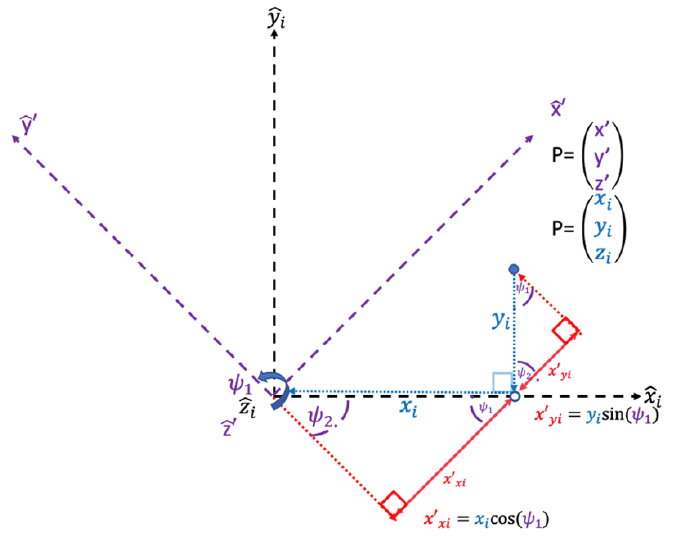
Figure 11. 3-rotation about the ˆ z i and ˆ z (cid:48) axes highlighting the pertinent similar right triangles.